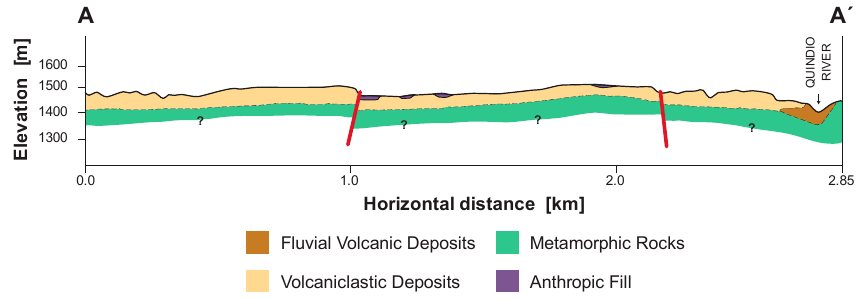
Figure 2. Geological cross-section of Armenia along the line marked AA’ in Figure 1. The thick red lines indicate normal faults.